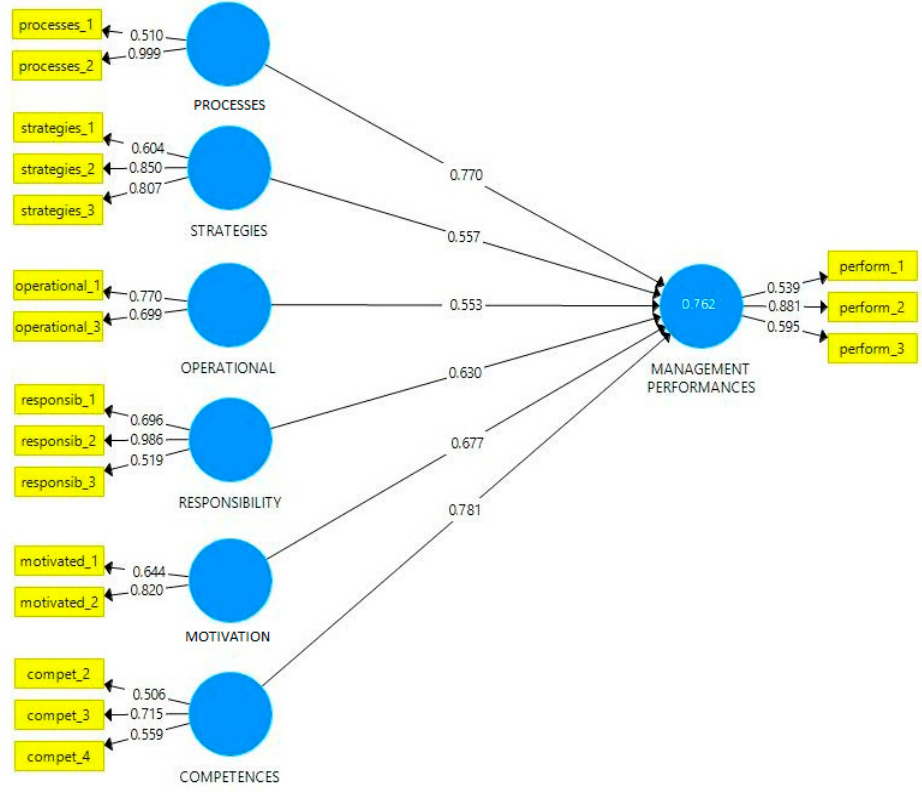
Figure 7. PLS – SEM Model 2. Figure 7. PLS–SEM Model